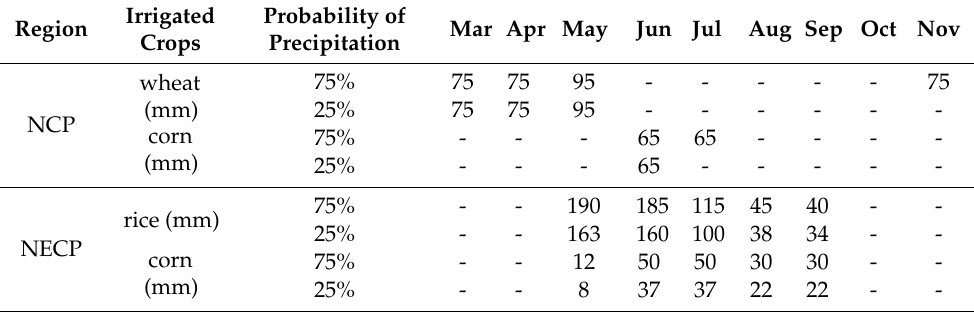
Table 1. The irrigation water requirements under the di ff erent precipitation probabilities based on previous studies and irrigation water quotas from the Beijing, Tianjin, Hebei, Henan,